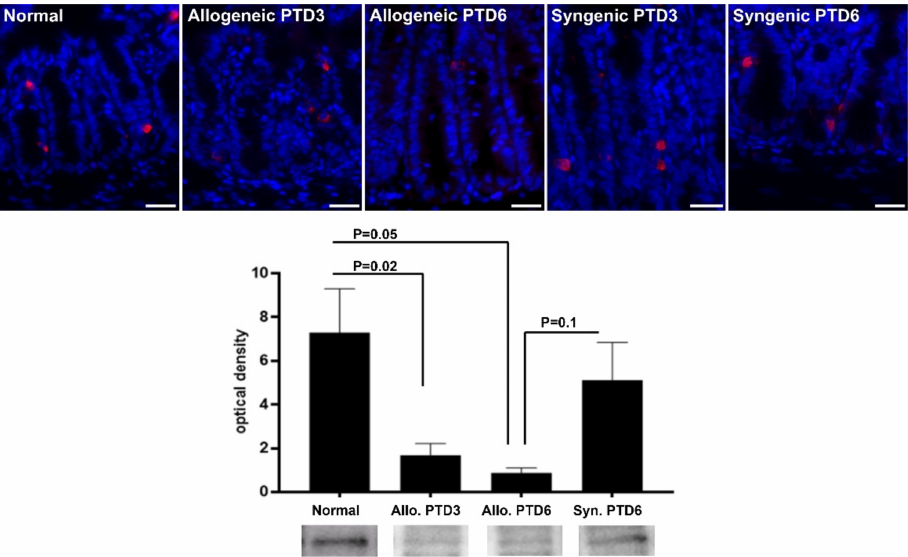
Figure 4. ( Upper panel ) Immunofluorescence microphotographs showing crypt cells positive for chromogranin A (red). Nuclei were stained blue using 40,6-diamidino-2-phenylindole. Original magnification 400 × , scale bar 25 µ m. ( Lower panel ) Western blot analysis for chromogranin A and representative immunoblot bands. The results from four separate experiments in each group are shown. PTD–post-transplant